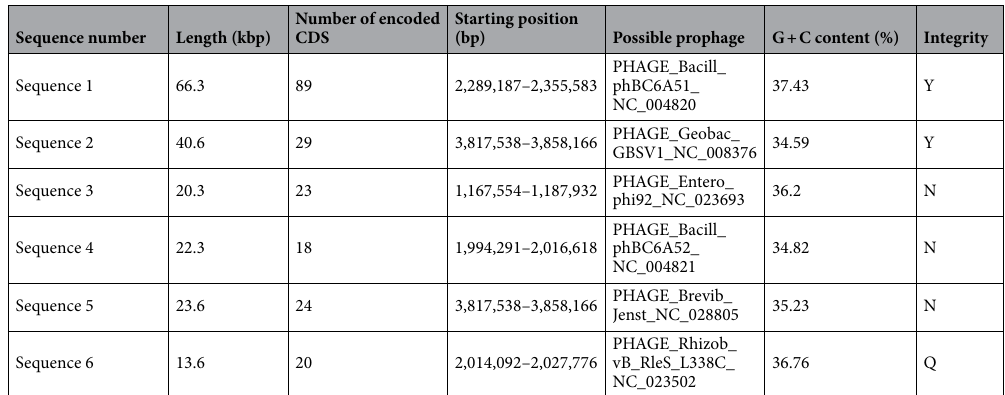
Table 6. The pro-phage sequences in the chromosome DNA of strain HD521. Y: complete; N: incomplete; Q: unknown.